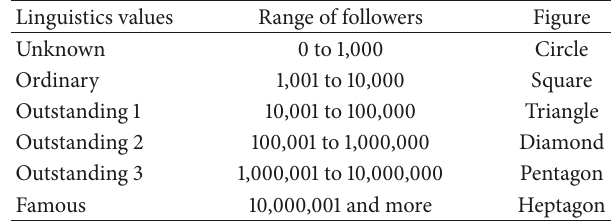
Table 1: Linguistic values and their range.